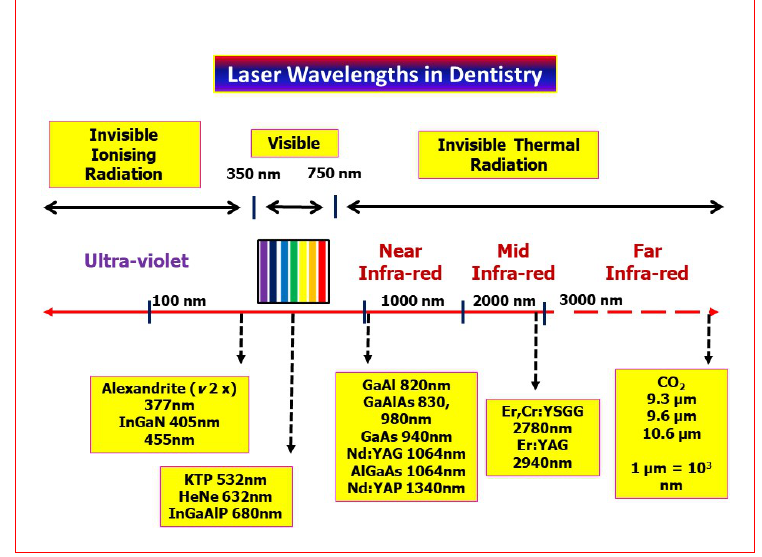
Figure 5. Laser wavelengths in common use in clinical dentistry, arranged according to wavelength in nanometers (10 −9 meters), from blue-visible to the far infra-red regions. The energy of emitted photons is expressed in Joules, or a derived equivalence, eV (a unit of energy equal to the work done on an electron in accelerating it through a potential difference of one volt), where 1 eV = 1.602 × 10 − 19 J. Since photonic energy and wavelength (λ) have an inverse proportional relationship, photons emitted from different active medium sources will have differing energy values. A basic expression of this relationship is demonstrated in equation 1, in which h = Plank’s constant, c = speed of light and E = photon energy in eV. λ = h c/E